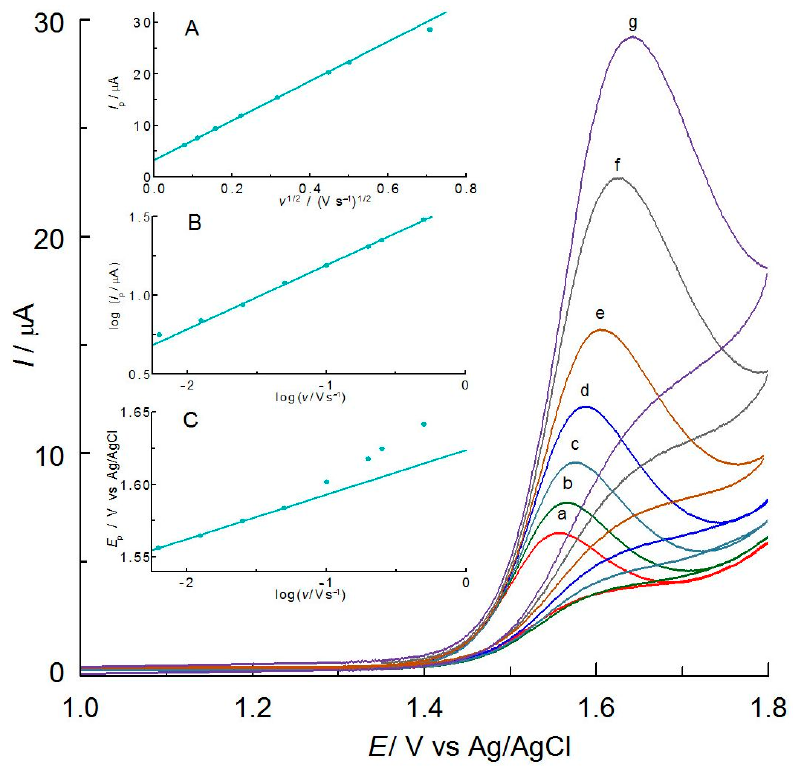
Figure 4. CVs for MIT oxidation (10.36 mg L − 1 ) on BDDE in C-PB solution (pH 5.6) at different scan rates: (a) 6.2; (b) 12.5; (c) 25; (d) 50; (e) 100; (f) 250; (g) 500 mV s − 1 . Insets: ( A ) the relationship between anodic peak currents, I p , and the square root of scan rate, v 1/2 ; ( B ) the dependence log I p = f(log v ); ( C ) the dependence E p = f(log v